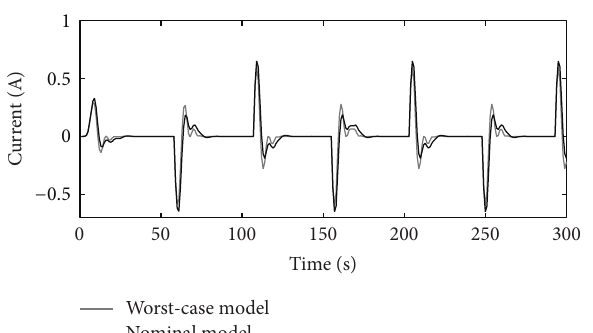
Figure 10: Step-reference tracking.